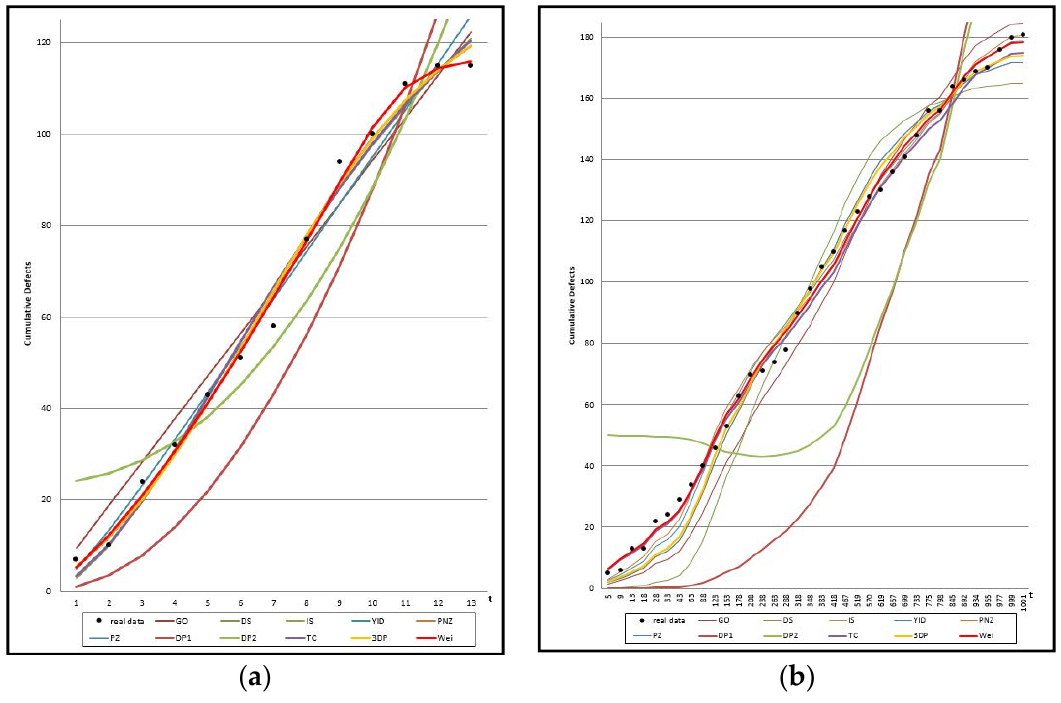
Figure 1. Mean value function of all 11 models; ( a ) Dataset #1; ( b ) Dataset #2. Appl. Sci. 2017 , 7 , 83